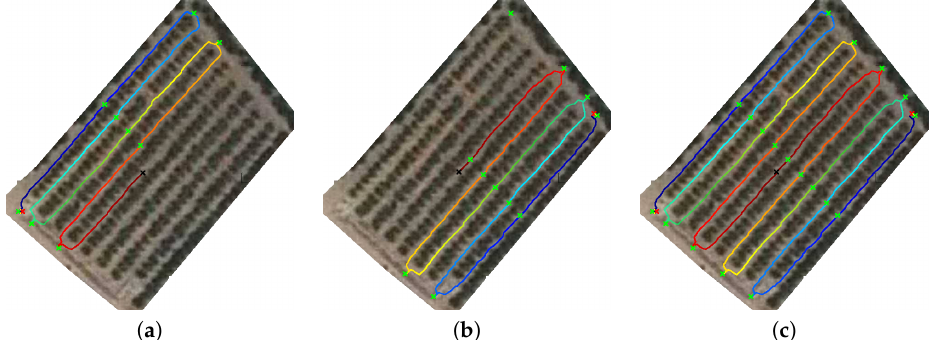
Figure 15. Determining path planning for a team composed by two robots (II). ( a ) real path for robot 1 , ( b ) real path planning for robot 2 , ( c ) superposition of (a) and (b).